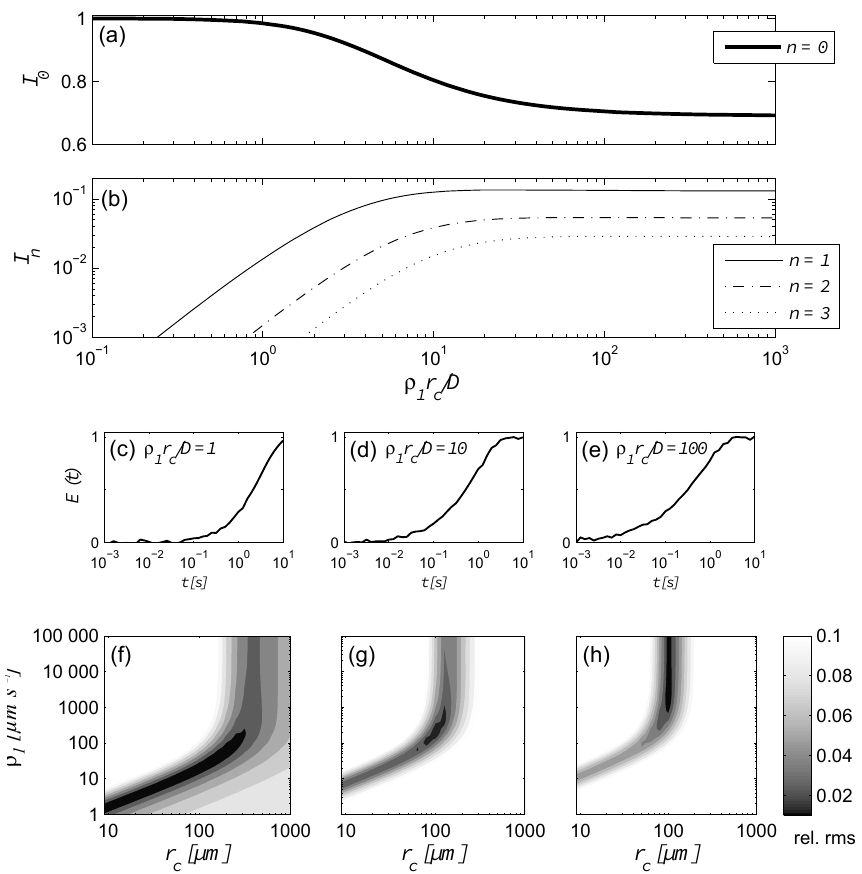
Figure 1. (a, b) Intensities of the zeroth to third relaxation modes as functions of the relationship ρ 1 r c /D visualising the different dif- fusion regimes in which NMR relaxation can take place, (c) – (e) simulated T 1 relaxation data for a capillary with (c) r c = 100µm and ρ 1 = 20µms − 1 , (d) r c = 100µm and ρ 1 = 200µms − 1 , and (e) r c = 100µm and ρ 1 = 2000µms − 1 , (f) – (h) corresponding results of a